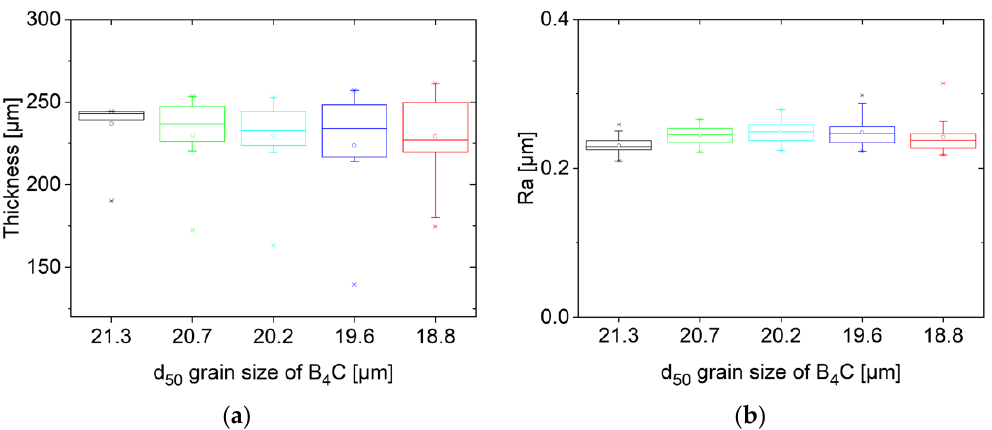
Figure 14. ( a ) Thickness variation for different abrasive grain sizes, ( b ) roughness values for different abrasive grain sizes.